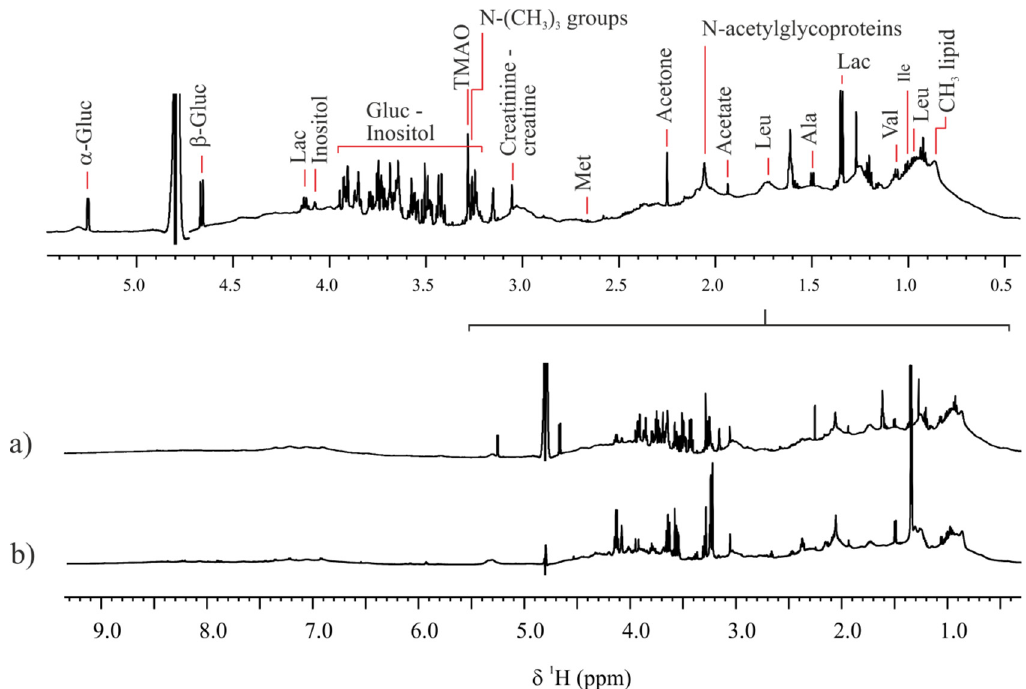
Figure 1. Representative 1H NMR spectra of follicular fluid samples of ( a ) adult and ( b ) prepubertal goats. Spectra were acquired at 298.0 K and at a magnetic field of 600 MHz, with suppression of the residual water signal.